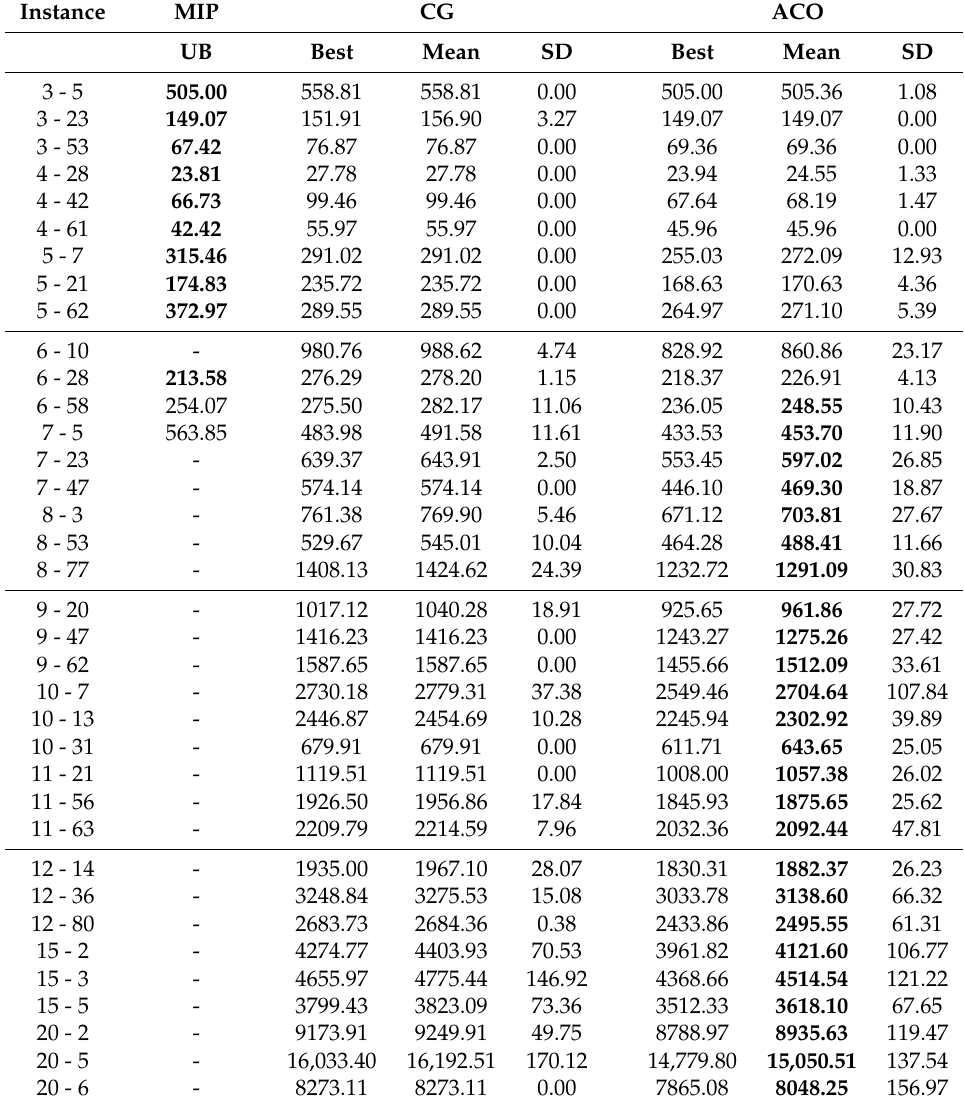
Table A3. MIP, CG and ACO for the RCJS problem. UB is the upper bound; Best is the best solution found across 25 runs; Mean is the average solution quality across 24 runs. The best results are highlighted in